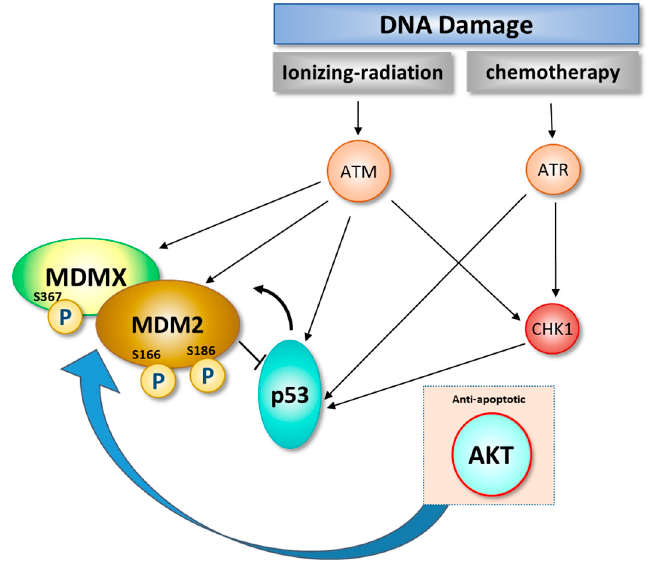
Figure 3. Regulation of the MDM2-signaling network by the pro-survival kinase AKT. AKT-mediated phosphorylation of Mdm2 promotes Mdm2 entry into the nucleus and enhances its ubiquitination- promoting function which leads to p53 inactivation, inhibition of apoptosis, and increased survival. Phosphorylation of MDMX by AKT stabilizes MDM2 E3-ligase